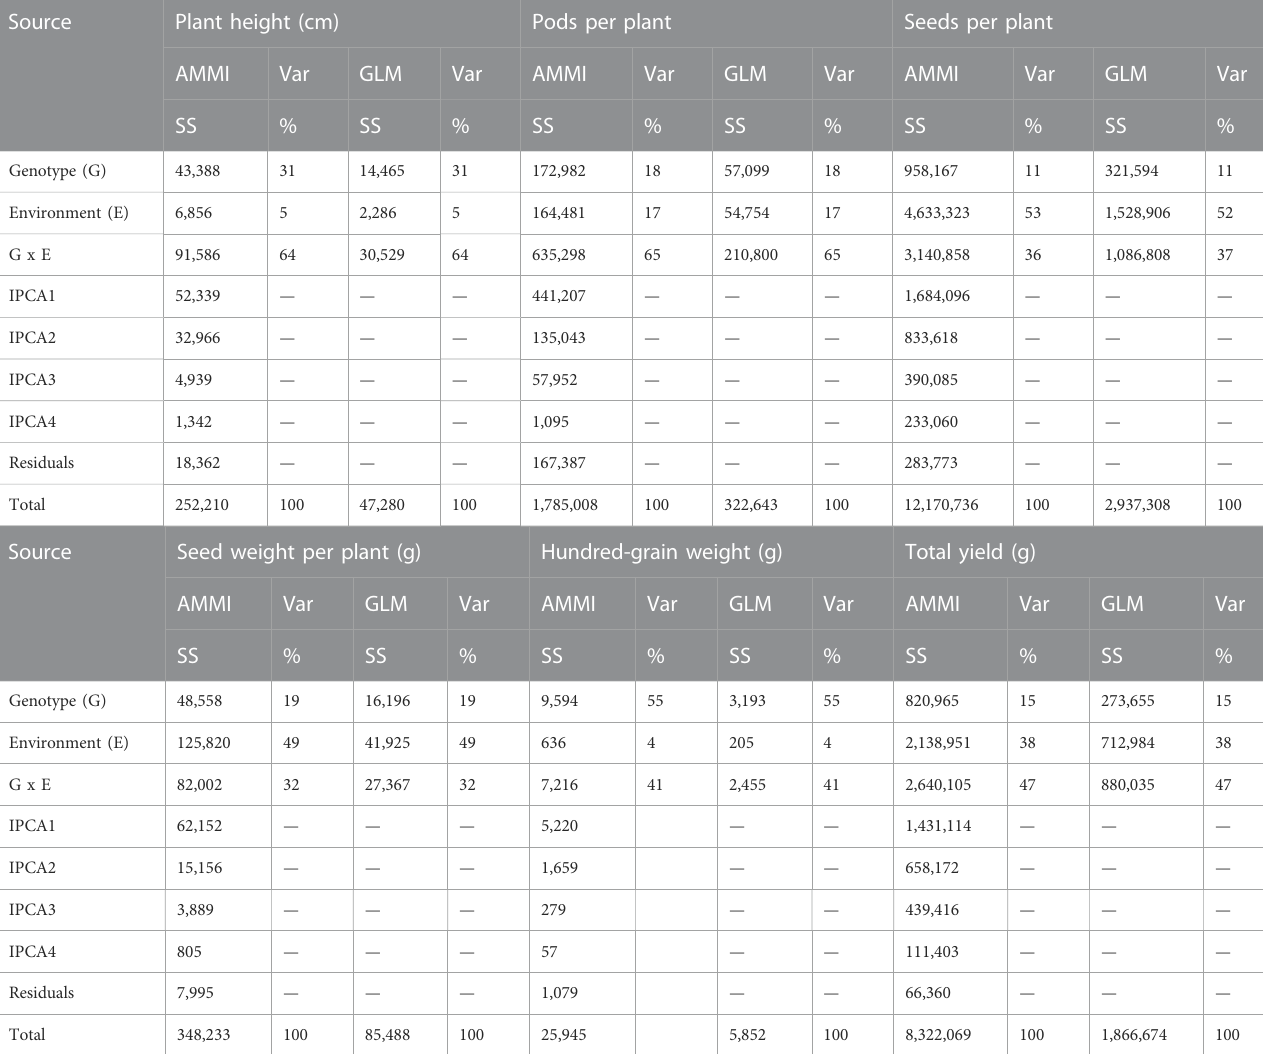
TABLE 1 Additive main effects and multiplicative interaction (AMMI) and generalized linear regression model (GLM) analysis of variance of the 96 soybean genotypes tested across fi ve environments. Source